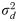
Recombination between strains across hosts.(A) Phylogenetic inconsistency between individual single nucleotide variants (SNVs) and core-genome-wide divergence for each of the species in Fig 2. The fraction of inconsistent SNVs is plotted for all 4-fold degenerate synonymous SNVs in the core genome with estimated age ≤d (S1E Text, part i). Singleton SNVs are excluded, because inconsistency can only be assessed for SNVs with ≥2 minor alleles. (B, inset) Linkage disequilibrium (LD) (σd2) as a function of distance (l) between pairs of 4-fold degenerate synonymous sites in the same core gene (S1F Text). Individual data points are shown for distances <100 bp, while the solid line shows the average in sliding windows of 0.2 log units. The gray line indicates the values obtained without controlling for population structure, while the blue line is restricted to the largest top-level clade (S2 Table, S1E Text, part ii). The solid black line denotes the neutral prediction from S1F Text; the only free parameters in this model are vertical and horizontal scaling factors, which have been shifted to enhance visibility. For comparison, the core-genome-wide estimate for SNVs in different genes is depicted by the dashed line and circle. (B) Summary of LD in the largest top-level clade for all species with ≥10 quasi-phaseable hosts. Species are sorted phylogenetically as in Fig 2B. For each species, the three dashes denote the value of σd2(l) for intragenic distances of l=9, 99, and 2,001 bp, respectively, while the core-genome-wide values are depicted by circles. Points belonging to the same species are connected by vertical lines for visualization.